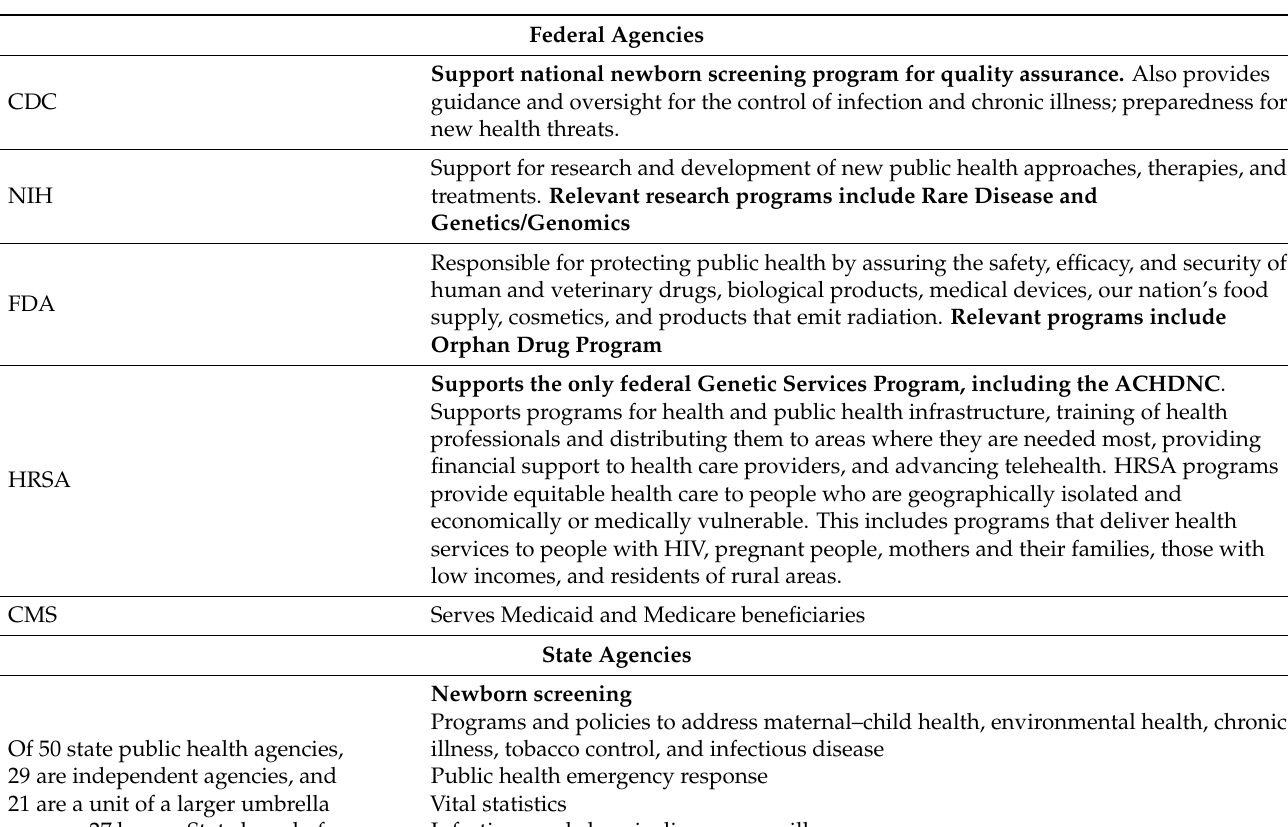
Table 1. Roles of US federal agencies in